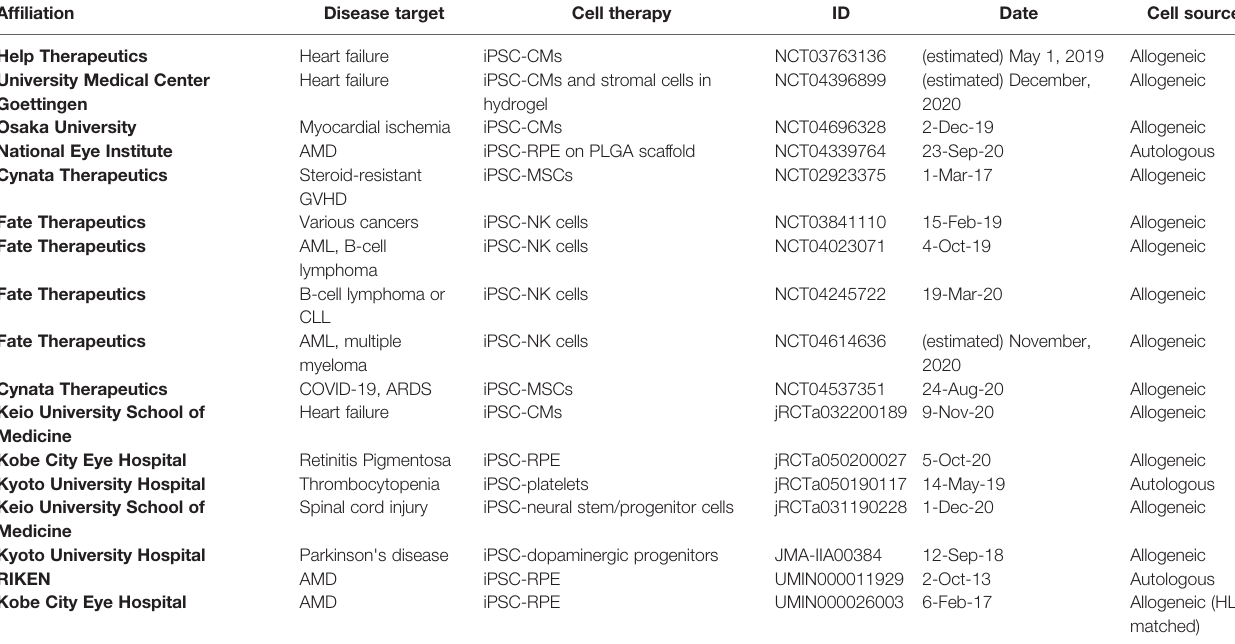
TABLE 1 | Registered clinical trials using